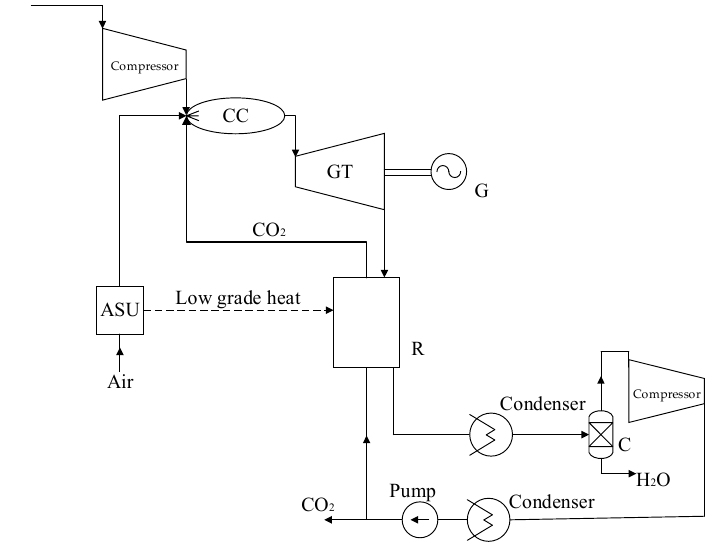
Figure 11. Allam cycle concept flow diagram.